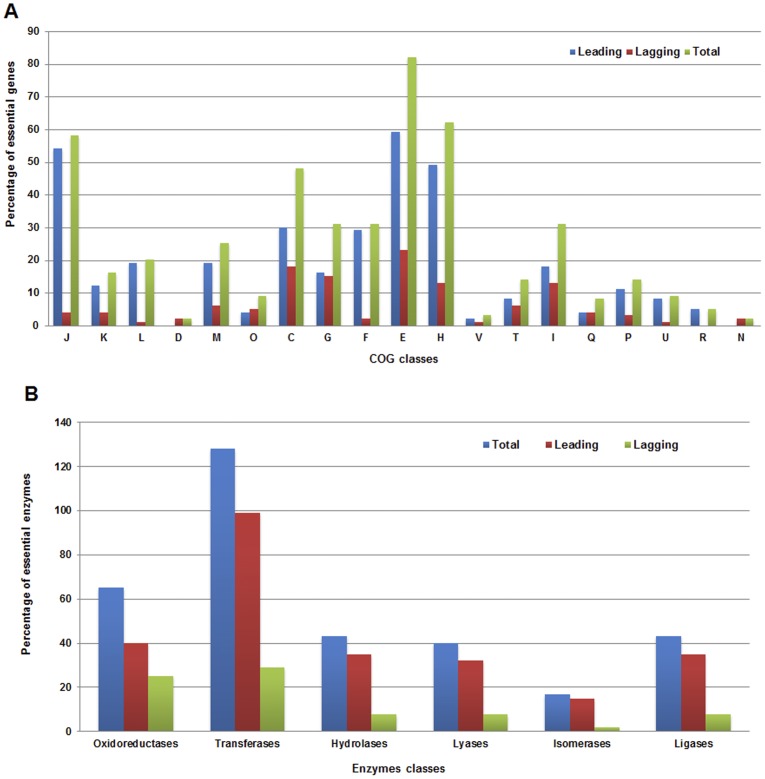
Evaluation of M. ulcerans essential genes via essential genes prediction features.(A) Percentage distribution of M. ulcerans essential genes on leading and lagging stands and among COG functional subcategories. (B) Percentage distribution of M. ulcerans essential genes on leading and lagging strands for six enzyme classes. Strand-bias towards different enzyme classes is also shown.